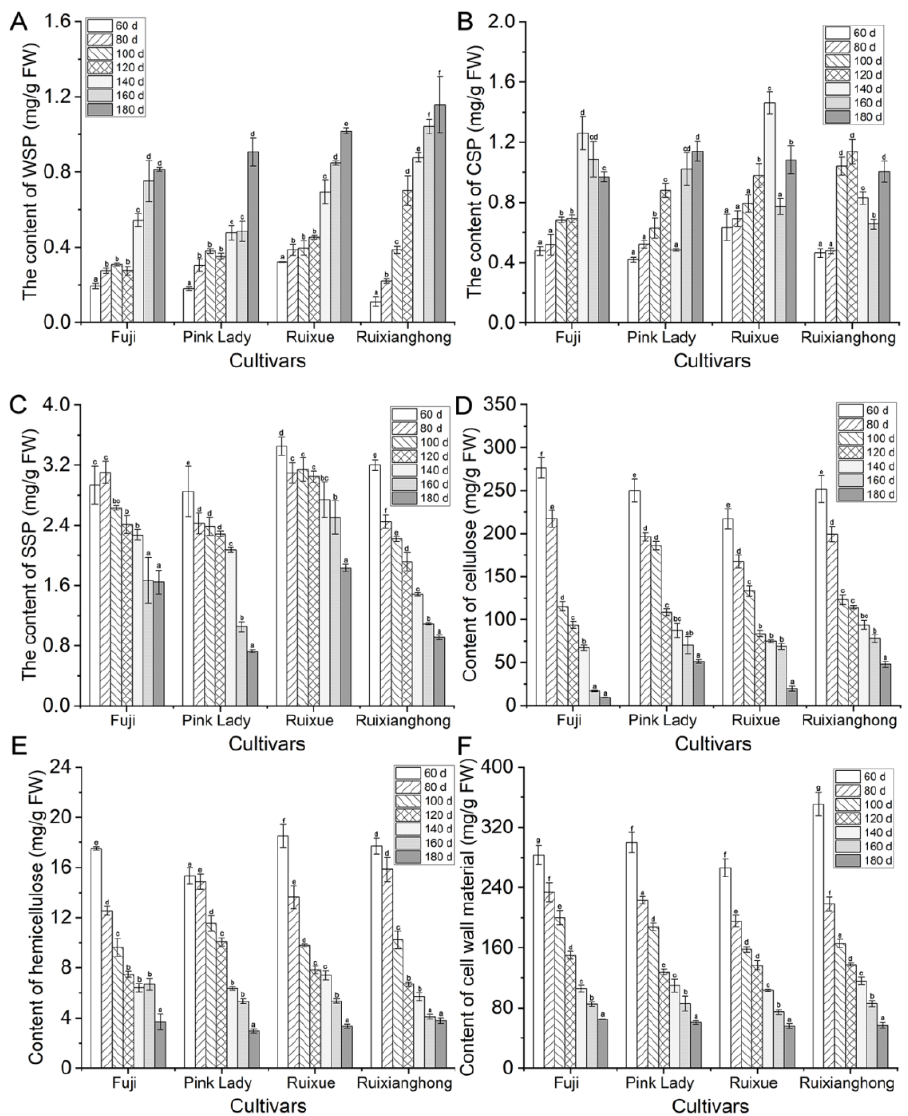
Figure 3. The alteration of cell wall polysaccharides in the ‘Ruixue’ and ‘Ruixianghong’ varieties and their parents apples during fruit development and ripening. ( A ) The content of water-soluble pectins (WSP), ( B ) chelator soluble pectins (CSP), ( C ) sodium carbonate soluble pectins (SSP), ( D ) cellulose, ( E ) hemicellulose, and ( F ) cell wall material. Different letters indicate significant differences between sampling dates for each cultivar ( p < 0.05).